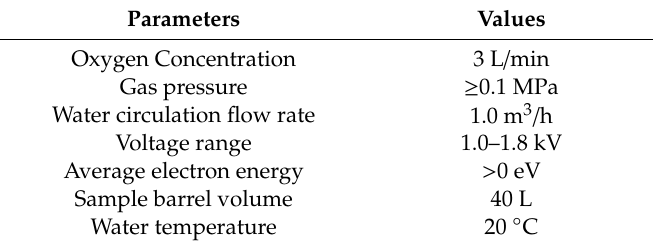
Figure 2. The schematic illustration of the experimental setup for the dielectric barrier discharge (DBD) system assisted nitrobenzene degradation with the illustration of the DBD reactor assembly. Table 1. The main characteristic conditions of the Dielectric Barrier Discharge (DBD)